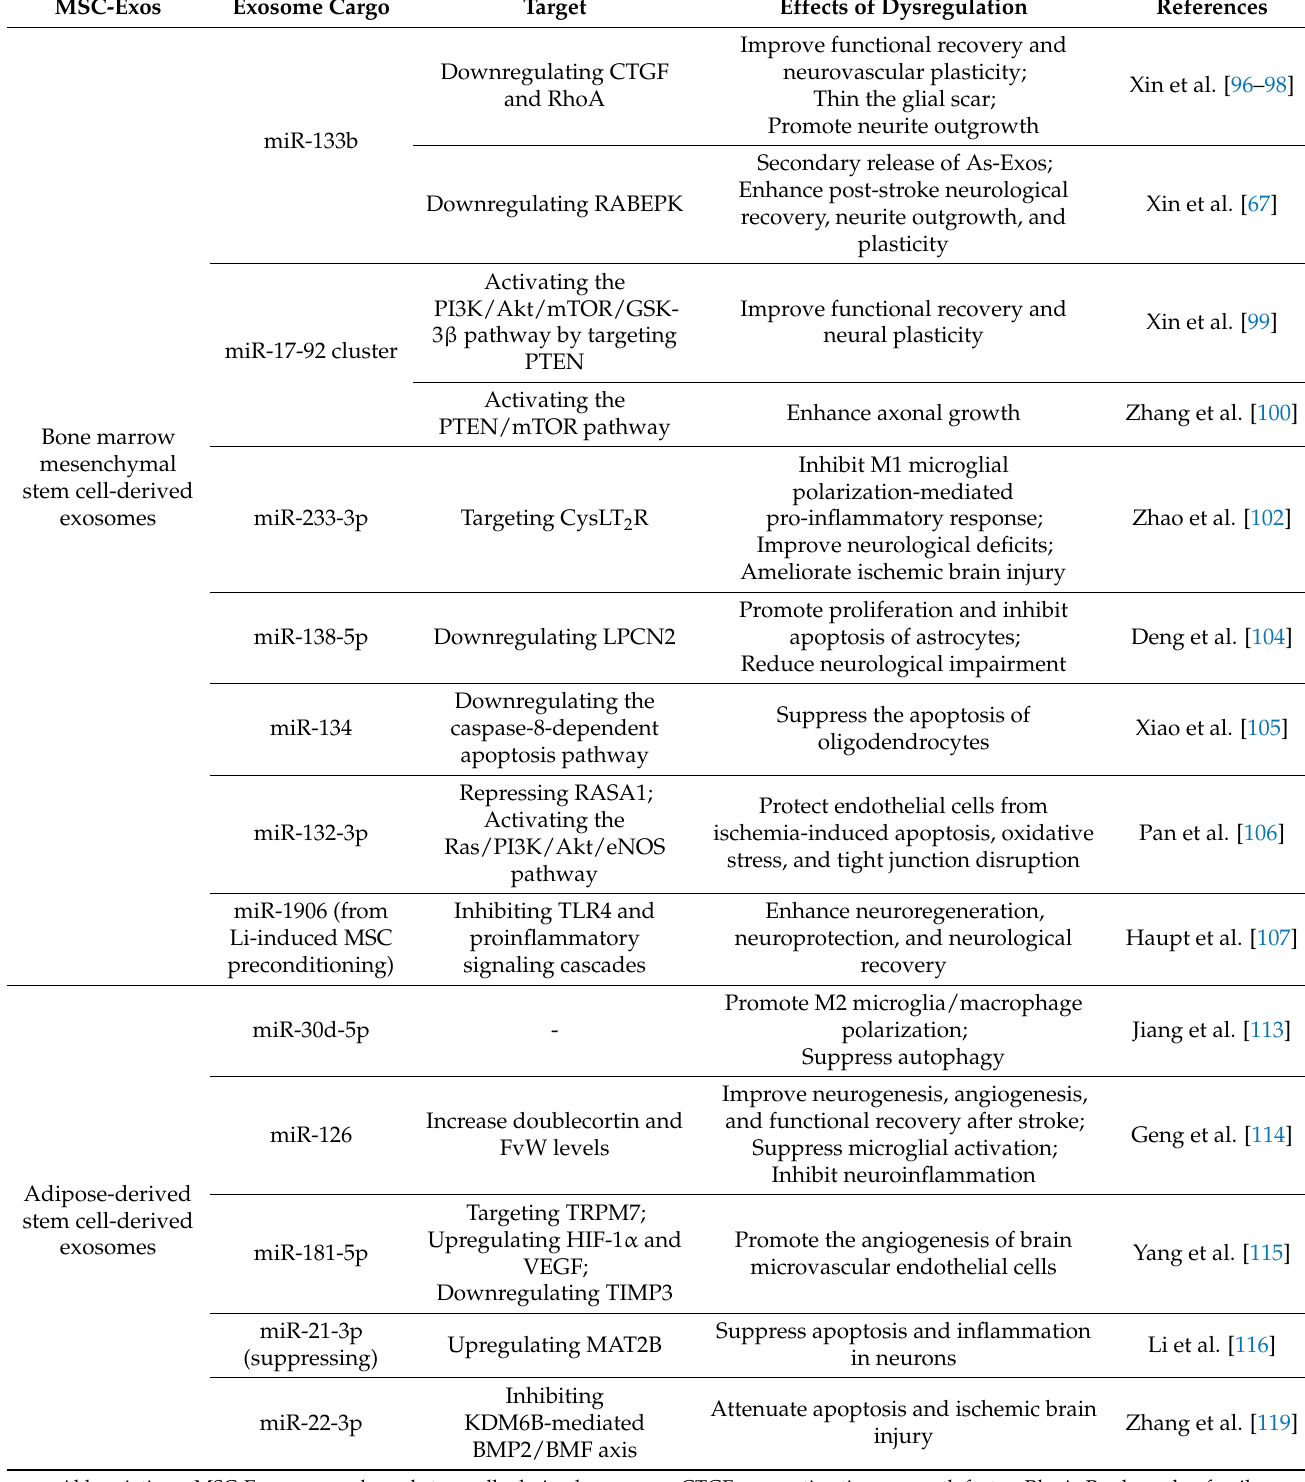
Table 2. Therapeutic potential of mesenchymal stem cell-derived